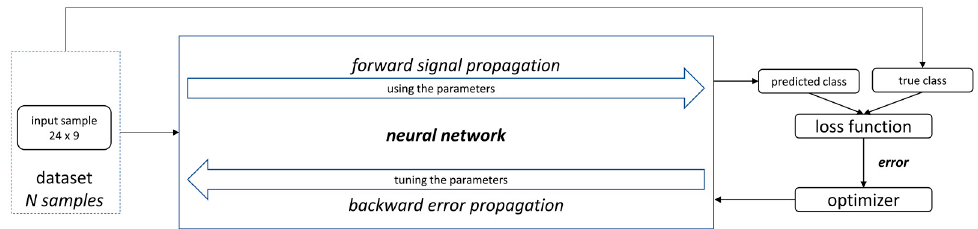
Figure 2. Neural network training.